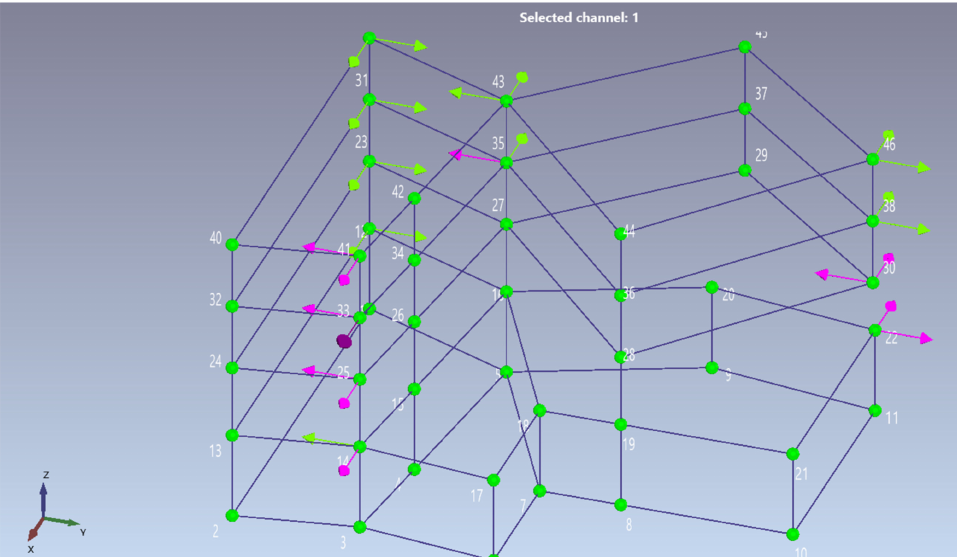
Figure 9. Model of the “Municipal Headquarters” of Palagianello defined in Artemis software. The arrows show the position and direction of each installed